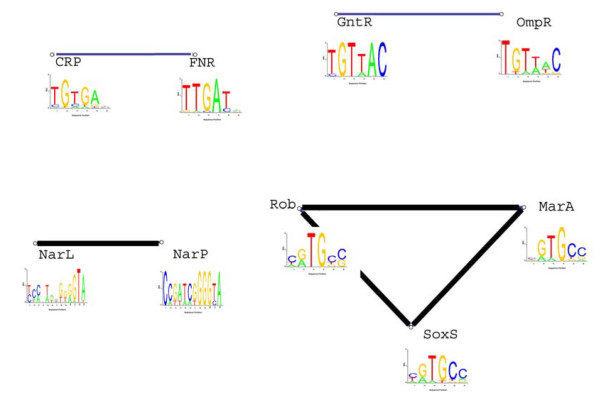
Transcription factors with overlapping binding sequences in E. coli. Nodes represent TFs, edges connect pairs of TFs if their corresponding sets of binding sequences have significant overlap according to the present measure. Bold edges connect TFs which also have biological similarity according to the functional annotation and transcription network (gene co-regulation) measure. Shown are the TF logos [11]. Logo length was limited to the highly conserved base pairs for clarity.